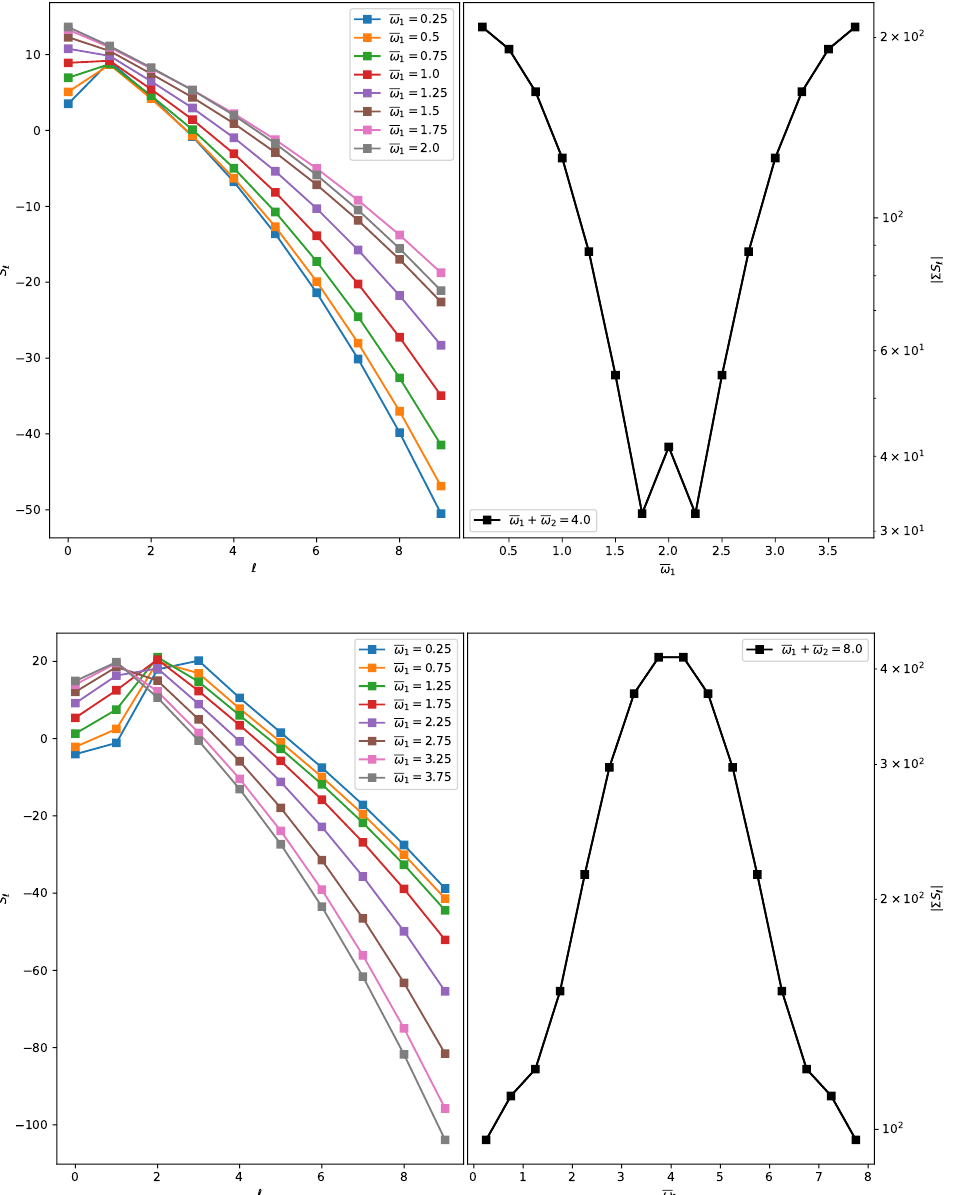
Figure 4. Evaluating (3.13) for m 2 = 0 in d = 4 . Above: S ‘ as a function of ‘ for a massless scalar with values of ω 1 and ω 2 chosen so that ω 1 + ω 2 = 4 . Below: the same plot but with values chosen to satisfy ω 1 + ω 2 = 8 so that contributions from R ( − +) are i‘